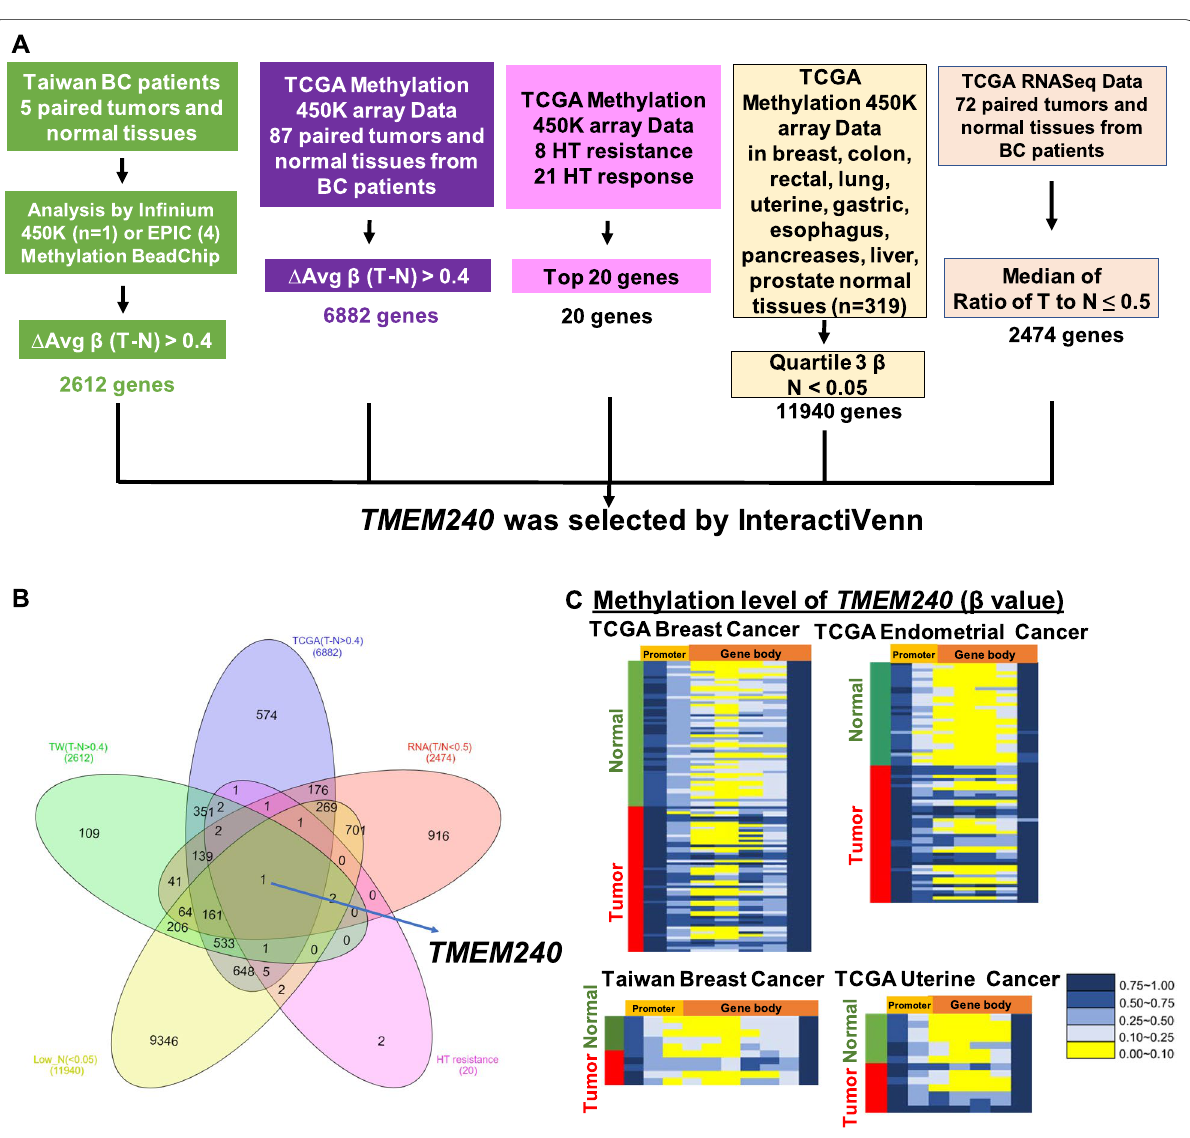
Fig. 1 Flowchart of gene selection and heatmap for TMEM240 . A The criteria and step‑by‑step flowchart for gene selection. B Screening of intersecting genes by InteractiVenn. C Heatmap of the TMEM240 methylation pattern in breast cancer and endometrial and uterine